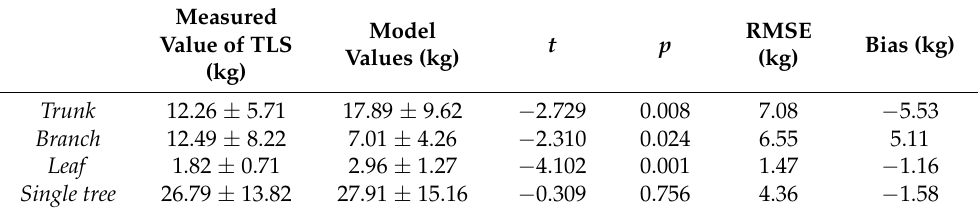
Table 3. Comparisons of each organ and the whole carbon stock for the sample wood measured by TLS and existing models.